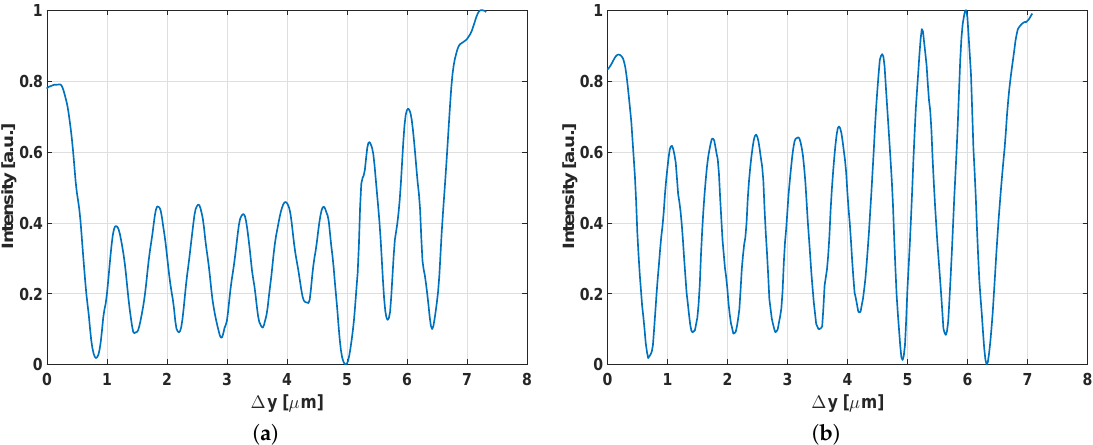
Figure 9. Line scans from the 300nm specimen of the test target at a fixed x-position with a 10 AU pinhole. ( a ) In-focus. ( b ) With PDM far